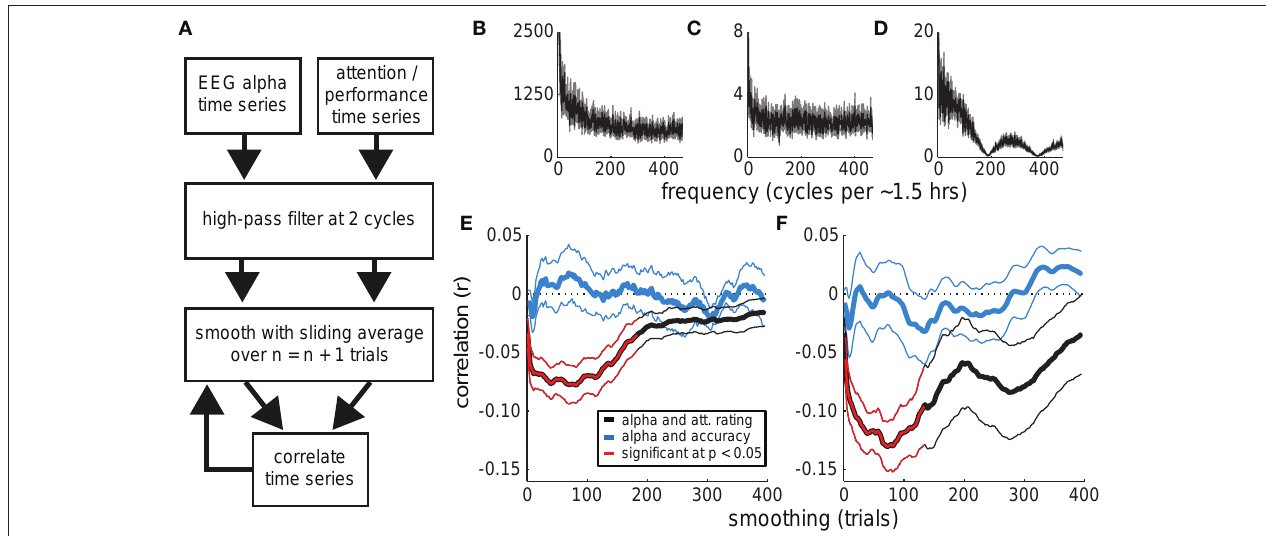
Figure 5 | Correlations between attentional state ratings, prestimulus eeg alpha power, and task performance (detection accuracy). (A) Flow chart illustrating the smoothing analysis. (B–D) Grand average Fourier power spectra of the trial-by-trial time series of attentional state ratings, prestimulus EEG alpha power, and detection task accuracy, respectively. The SE of the mean is shown in gray. (e,F) Grand average correlations ( r ) as a function of the degree of smoothing (sliding window size). The correlations between the time series of